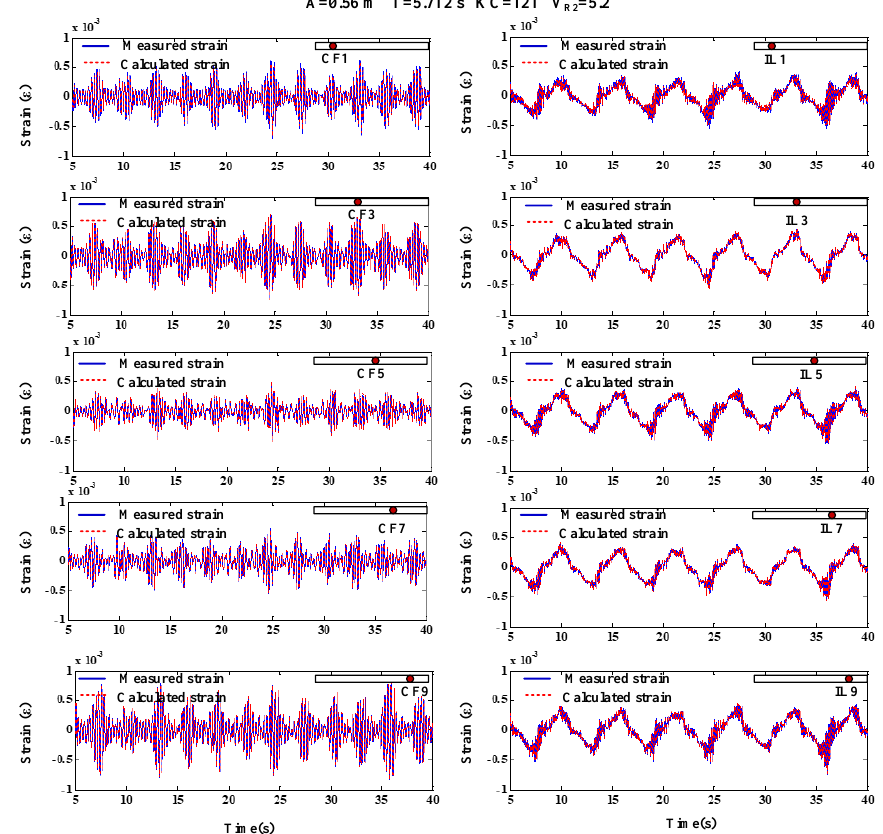
Figure 6. Time history of measured and calculated strain at different gauge points in both the CF and IL directions for KC = 121 and V R2 = 5.2.